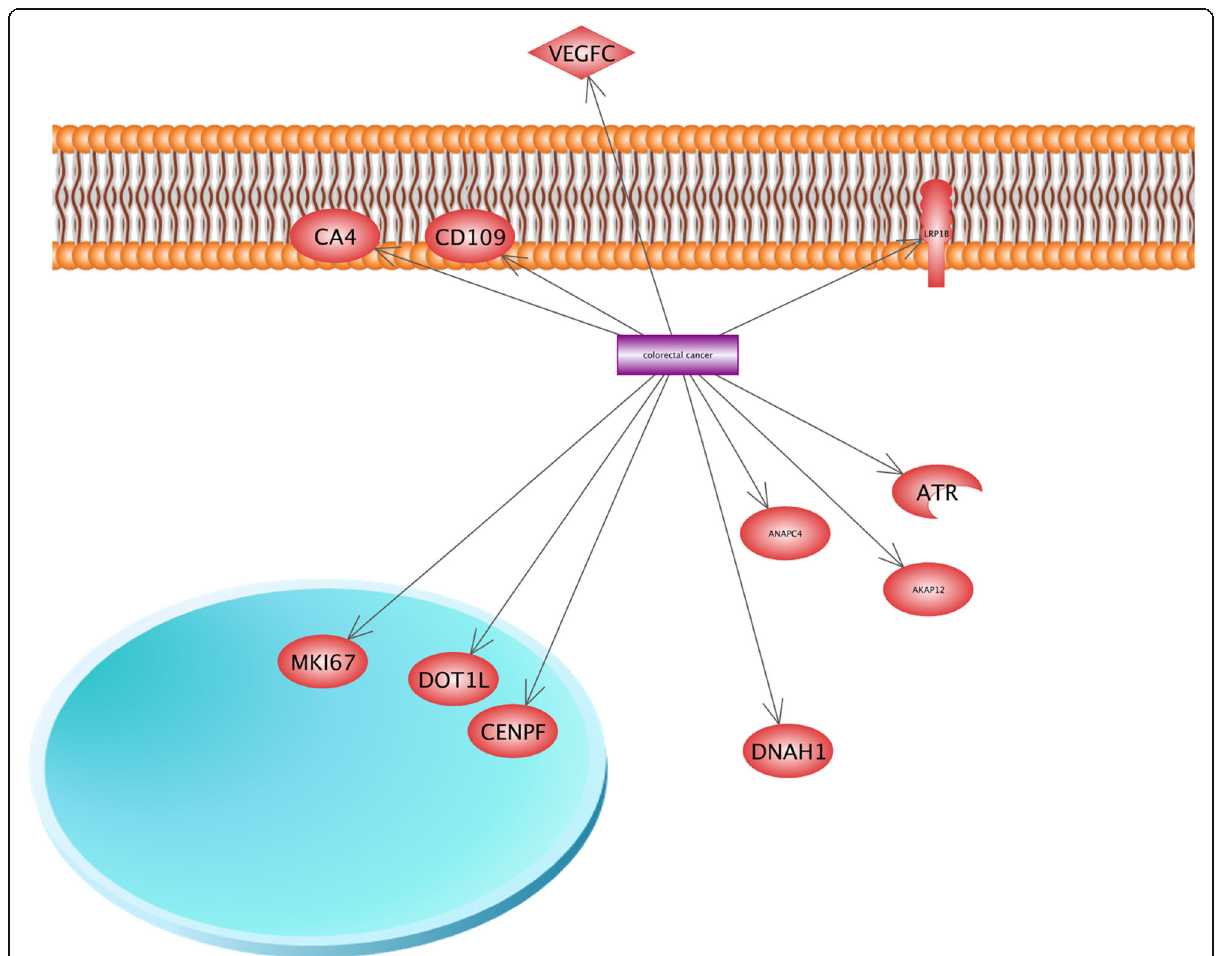
Fig. 10 The role of the hypoxia-regulated gene in colorectal cancer. We found that ATR serine/threonine kinase is known as the DNA damage sensor, and is also activated upon genotoxic stresses such as ionizing radiation, ultraviolet light, and DNA replication stalling. For instance, it has a regulatory role in the response to DNA double-strand breaks. It is reported that the mutation in ATR serine/threonine kinase leads to a wide variety of types of